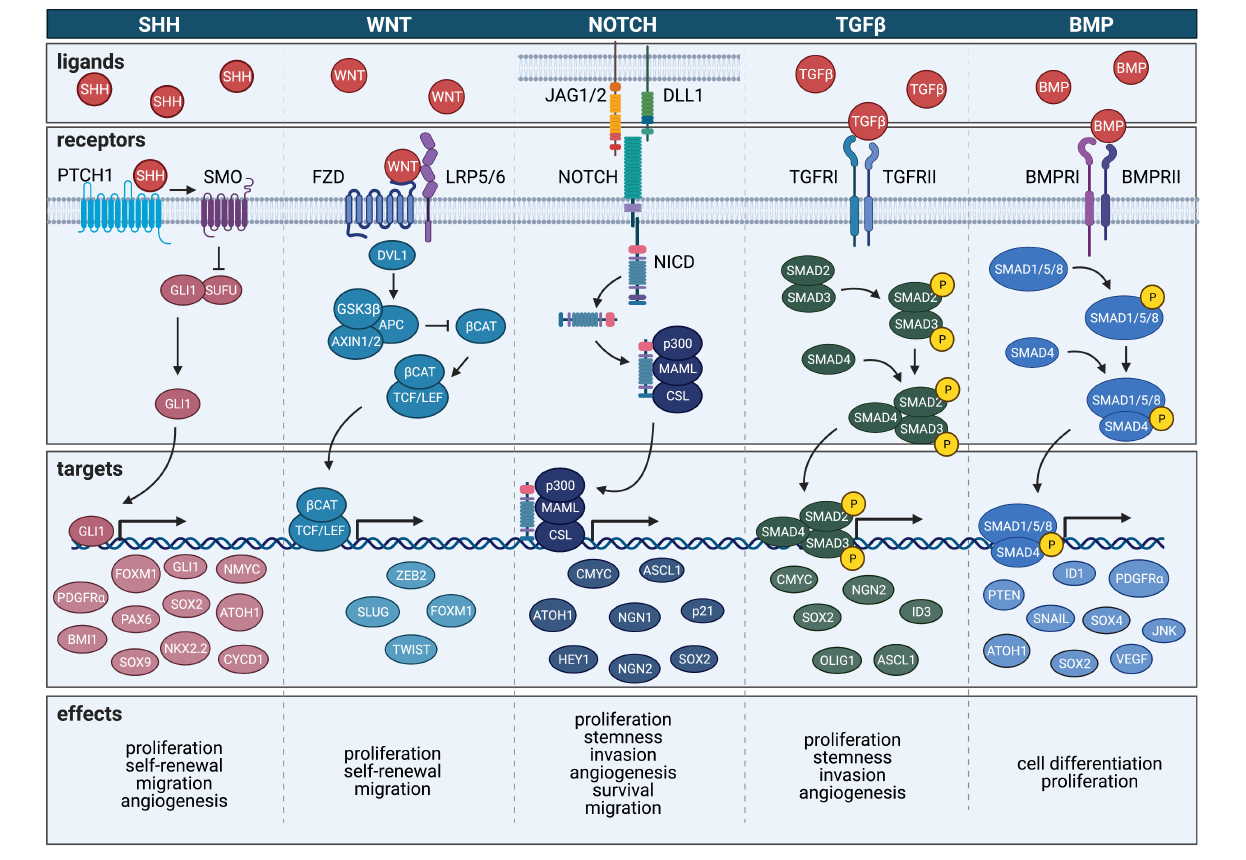
FIGURE 3 | Crosstalk occurring between neurodevelopmental signaling pathways and transcriptional regulation in brain